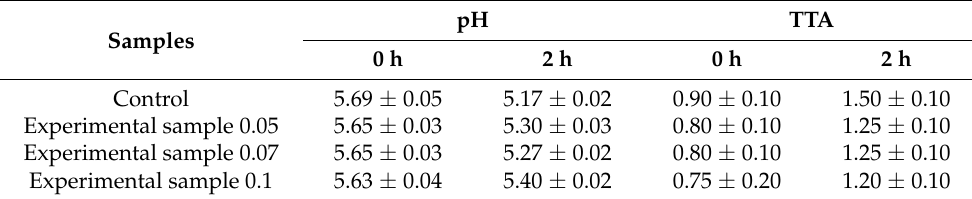
Table 1. Kinetics of acidification during fermentation.